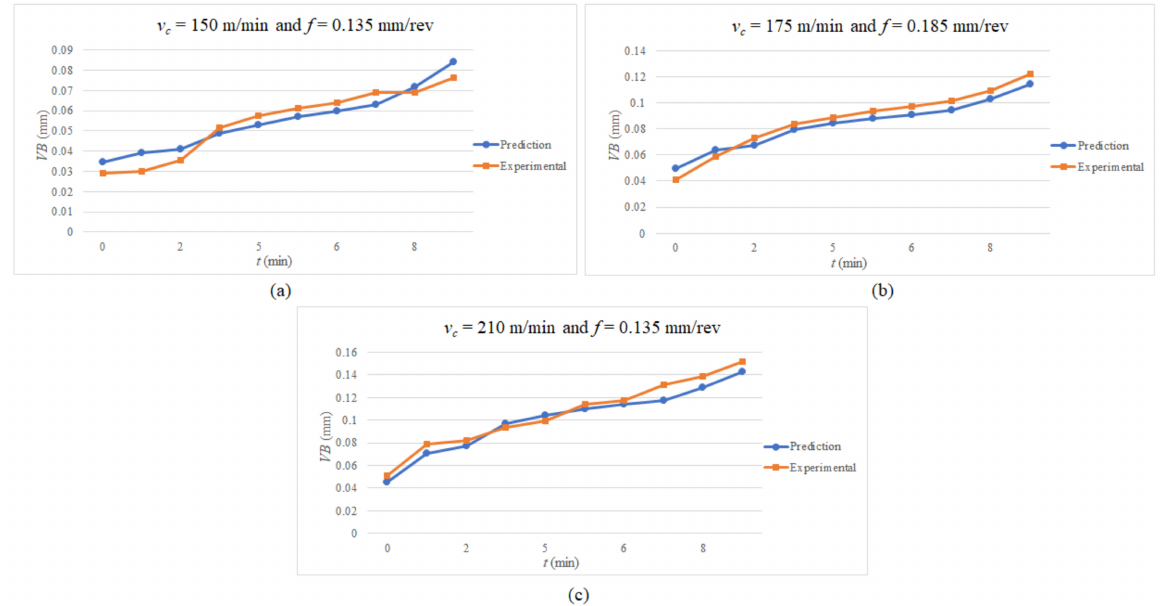
Figure 6. Flank wear at ( a ) v c = 150 m/min, f = 0.135 mm/rev; ( b ) v c = 175 m/min, f = 0.185 mm/rev; ( c ) v c = 210 m/min, f = 0.135